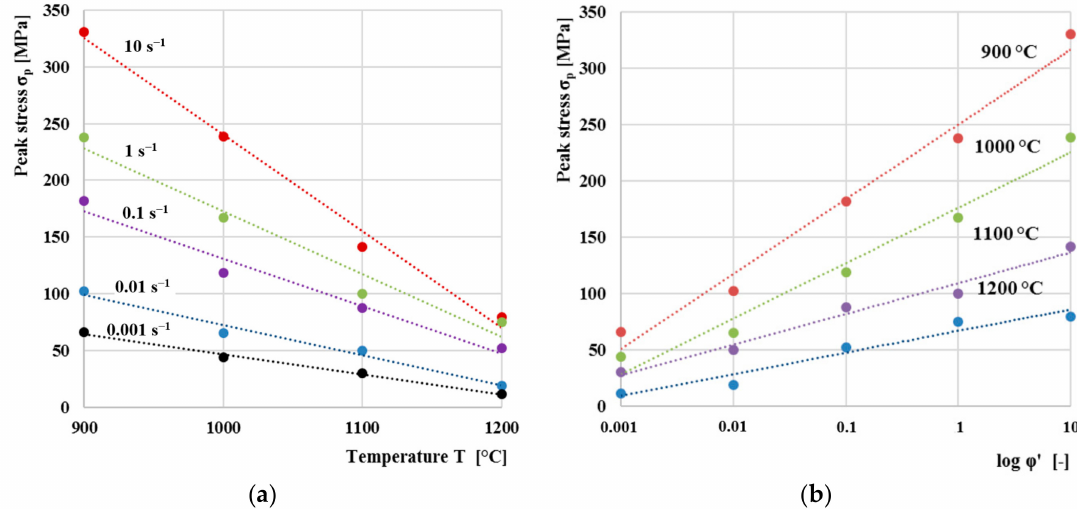
Figure 14. ( a ) dependence of strain resistance on temperature for individual strain rates; ( b ) dependence of strain resistance on strain rates for individual